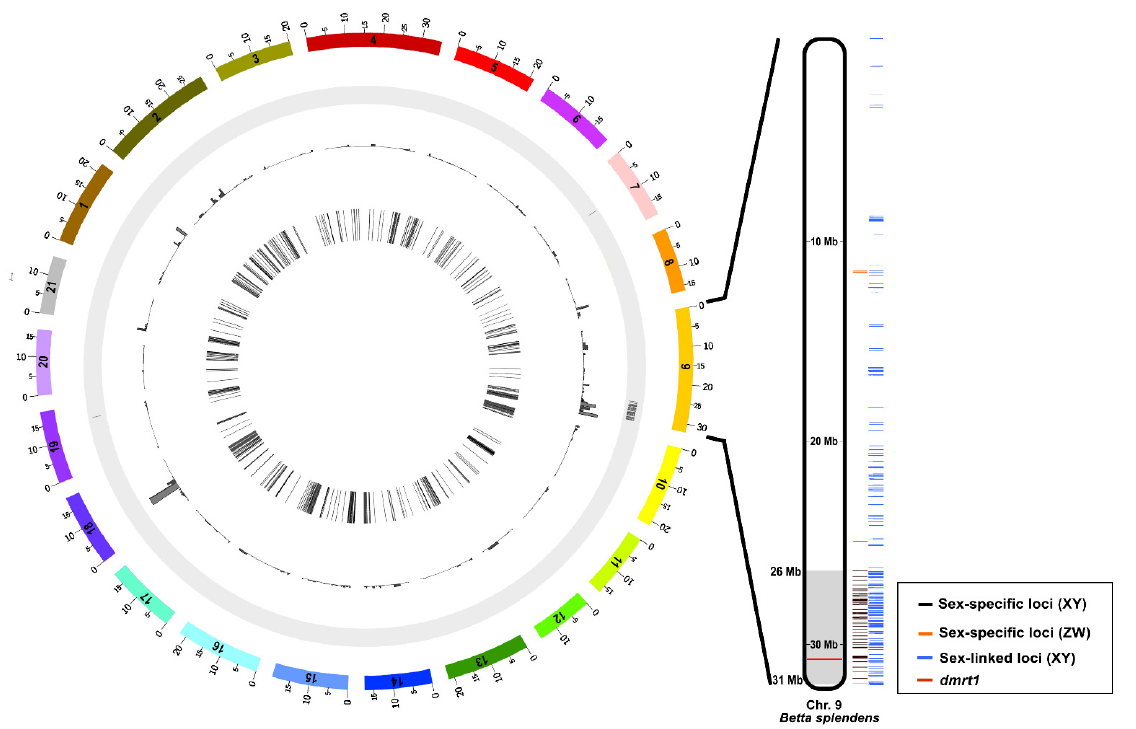
Figure 4 . Circos plots showing the distribution of sex-specific and sex-linked loci in Siamese fighting fish ( Betta splendens Regan, 1910)